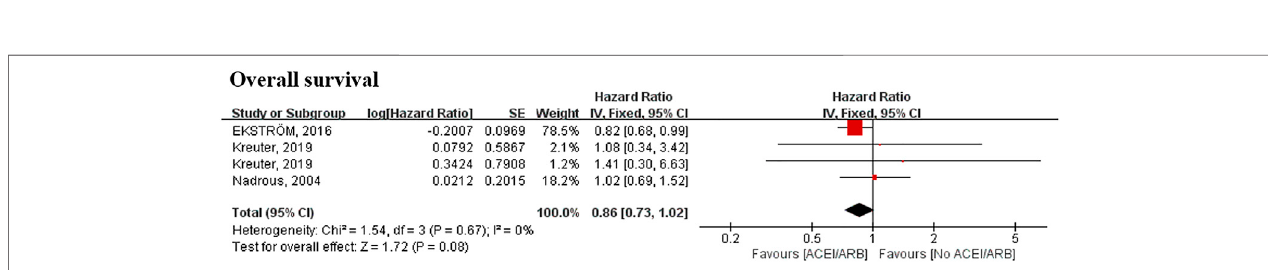
FIGURE 3 | Meta-analyses of the included studies examining overall survival and FVC for statin vs. no statin. The marker size indicates the relative weight of the study, as it contributes to the results of the overall comparison. IV indicates inverse-variance random-effects analysis; HR, hazard ratio; FVC, forced vital capacity.